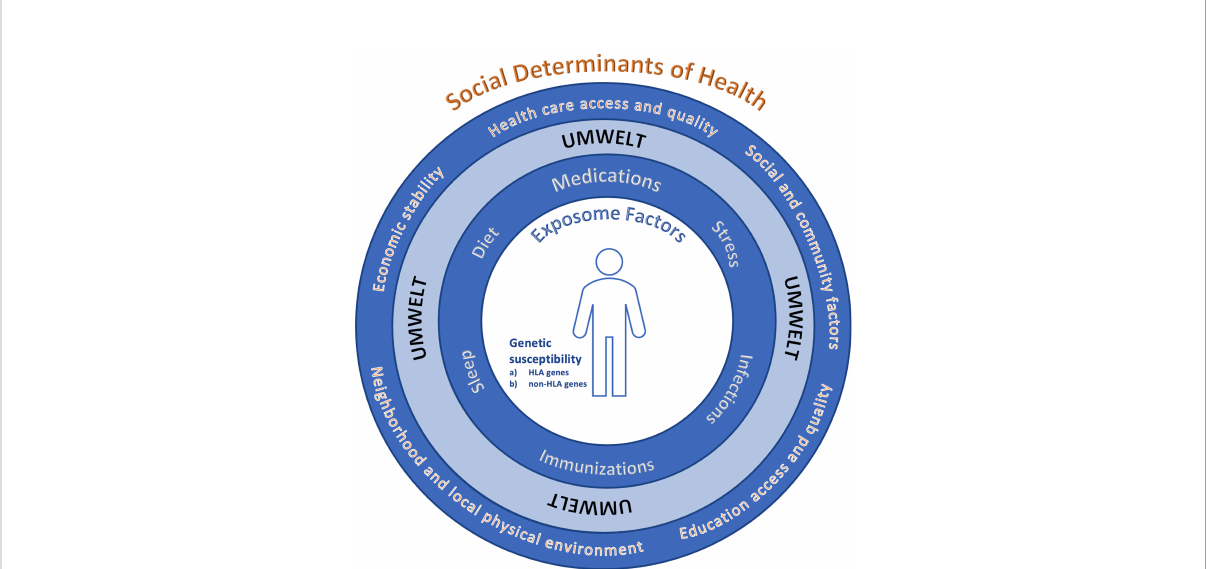
FIGURE 2 Multifactorial complexities of disease. There is an interplay of: 1) internal genetic factors including (A) HLA genes and (B) non-HLA genes, and 2) external environmental factors (an individual ’ s umwelt) that is compromised of both a) exposome factors (including medications, diet, sleep, immunization, infections, stress), and key social determinants of health (SDOH*, including health care access and quality, social and community factors, education access and equality, neighborhood and local physical environment, economic stability) that are inextricably linked and interwoven in a dynamic fashion to set the thresholds for autoimmune susceptibility, disease induction, the severity and course of disease and treatment response. The overall balance and factors is likely to vary across various autoimmune conditions, phenotypic subtypes of disease and the evolution of clinical expression within individuals.